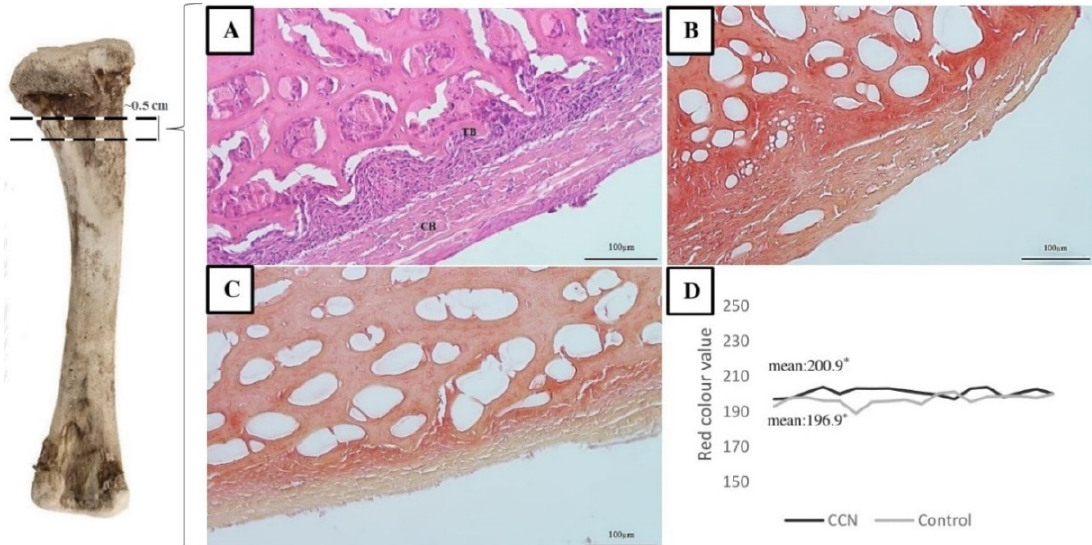
Figure 7. Histological cross sections from proximal metaphysis of broiler chicken male femoral bone. Femur after H&E staining ( A ). Alizarin red staining for mineralization (calcium deposits) for broiler chicken after IOI with CCN ( B ) and without IOI ( C ). Higher red colour intensity value suggests better calcification of the bone ( D ). TB: trabecular bone; CB: compact bone. * The value next to the averages differs significantly at p ≤ 0.05.